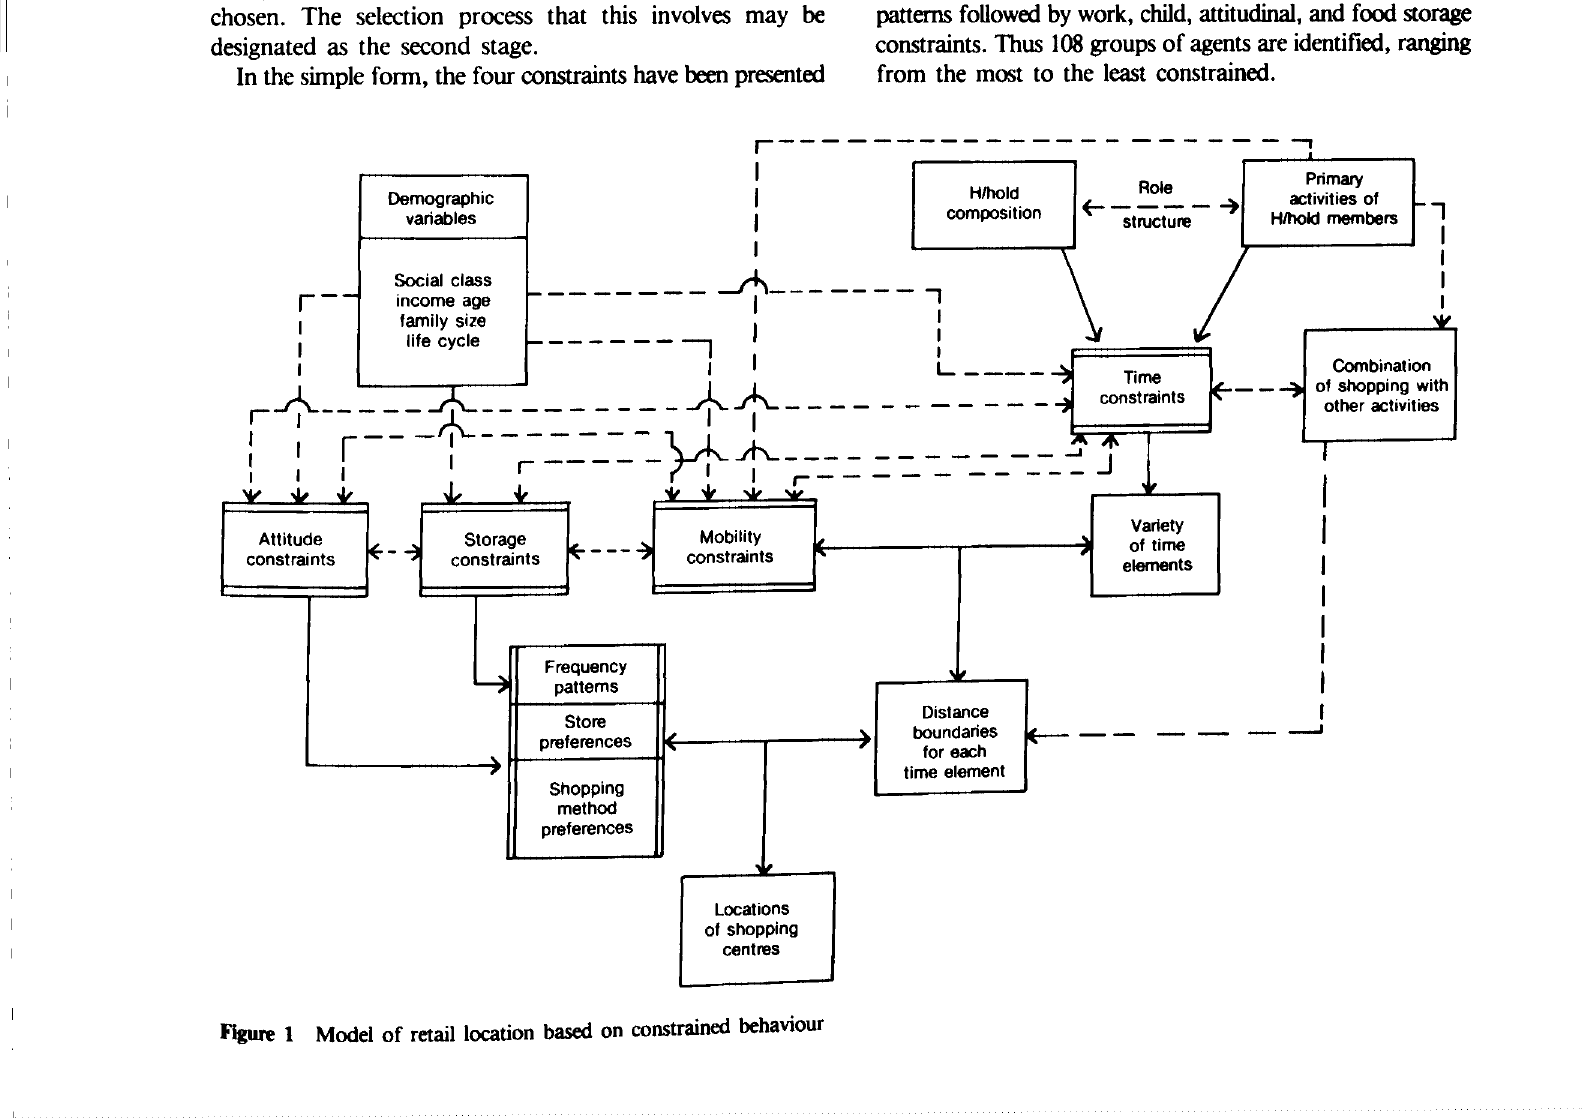
Figure 1 Model of retail location based on constrained behaviour